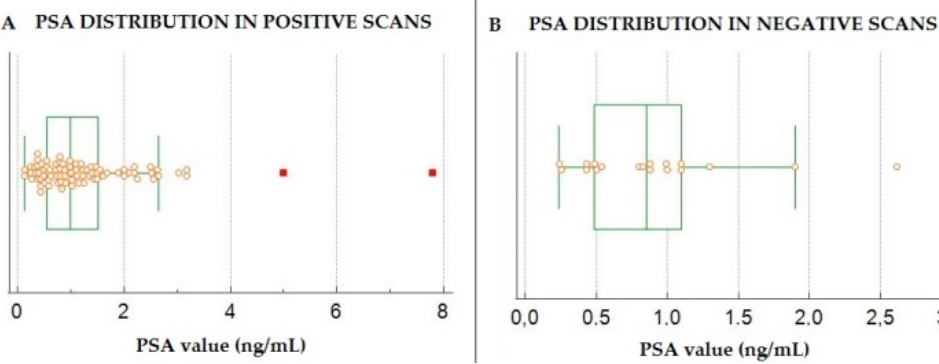
Figure 4. Box plot graph showing the PSA level distribution in patients with positive ( A ) and negative ( B ) 18 F-FABC PET/CT scans, 2-tailed t -test results were significant at p = 0.005. The 2 hot dots in panel A represent 2 subjects with PSA value strongly out of range (i.e., 5 and 7.8 ng/mL, respectively).